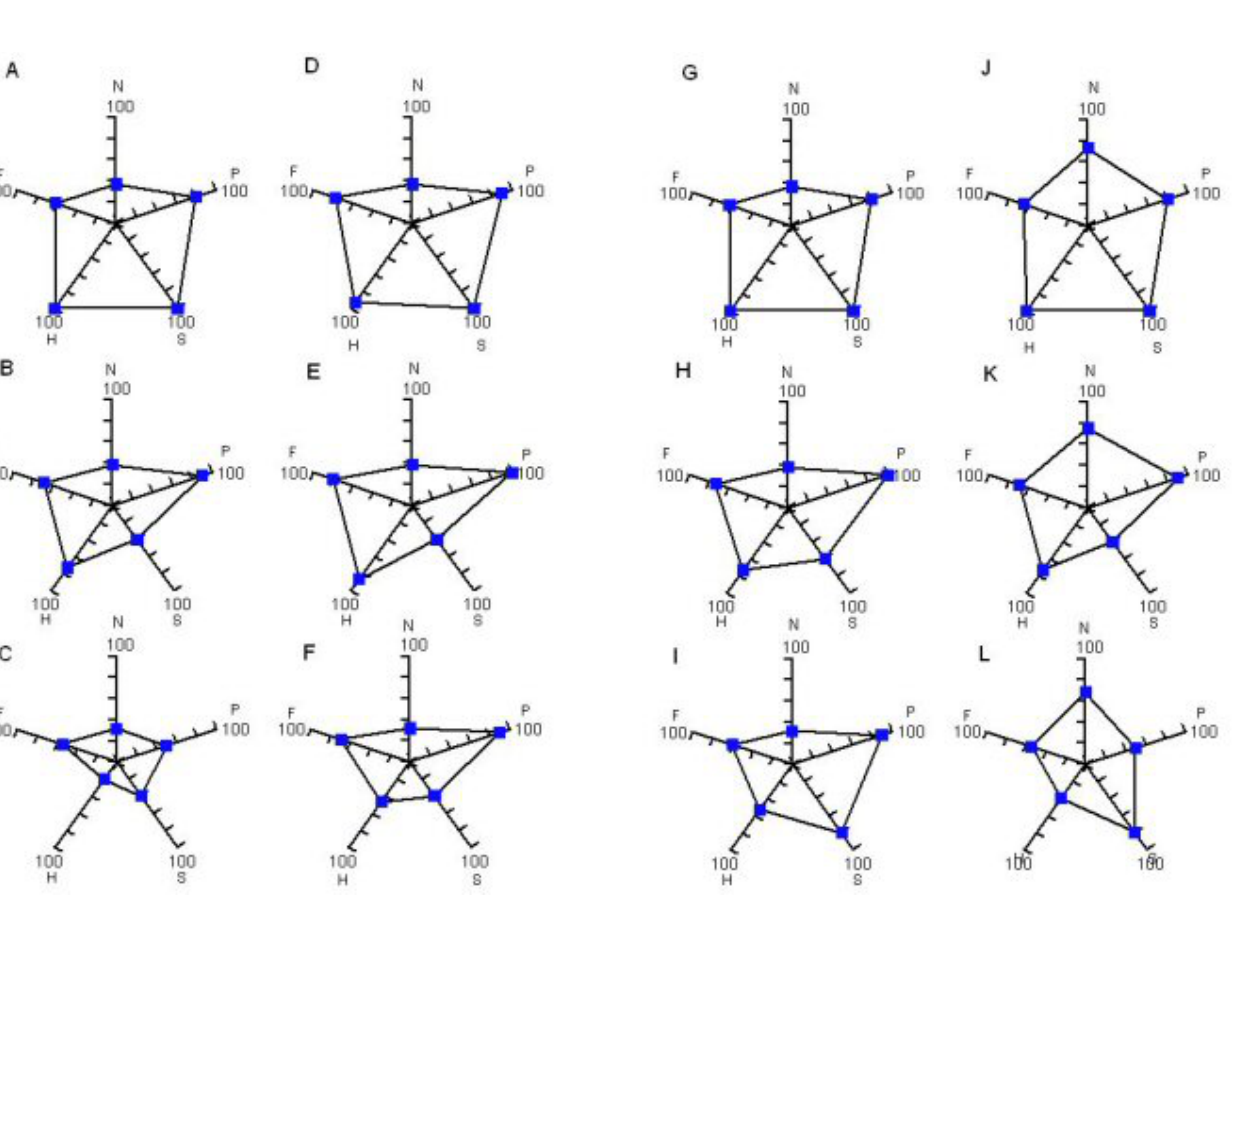
Fig. A7.4. Radar diagrams illustrating the predicted impacts of different policy interventions on the availability of different asset types for commercialization of different NTFPs. Three NTFP case studies are presented, illustrating the range in outputs derived for the entire set of 19, namely: A–Hongos (Cuajimoloyas); B–Maguey (La Esperanza); C–Jipi Japa (El Carmen Surutú). The values presented are probabilities associated with the asset being of “high” availability, as inferred by the BBN when instantiated using data for the individual case studies. Abbrevations for capital asset types: N–natural; P–physical; S–social; H–human; F–financial. The first column presents values for the NTFP case studies as determined by the CEPFOR research, representing the current situation. The three subsequent columns illustrate predictions according to three policy interventions, respectively: (1) provide credit for community-level NTFP-based enterprises, (2) improve rural transport and communication infrastructure, and (3) promote better management of the communal natural